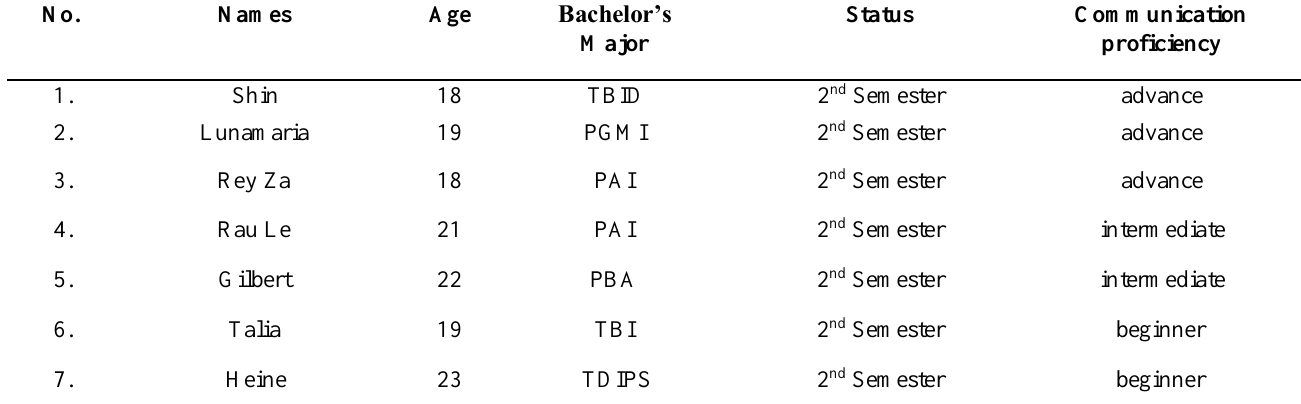
TABLE 2 | Contributor’s associated data